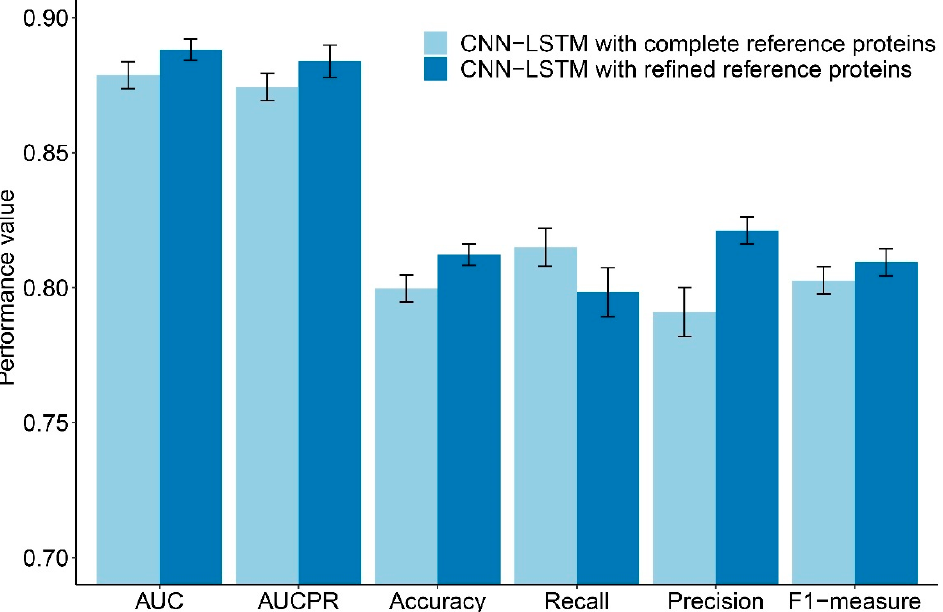
Figure 1. Average performances of CNN-LSTM with the complete reference proteins compared to CNN-LSTM with the refined reference proteins. The error bar indicates the standard deviation. The average AUC, AUCPR, Accuracy, Precision, and F1-measure of CNN-LSTM with the refined reference proteins are greater than the average performances of CNN-LSTM with the complete reference